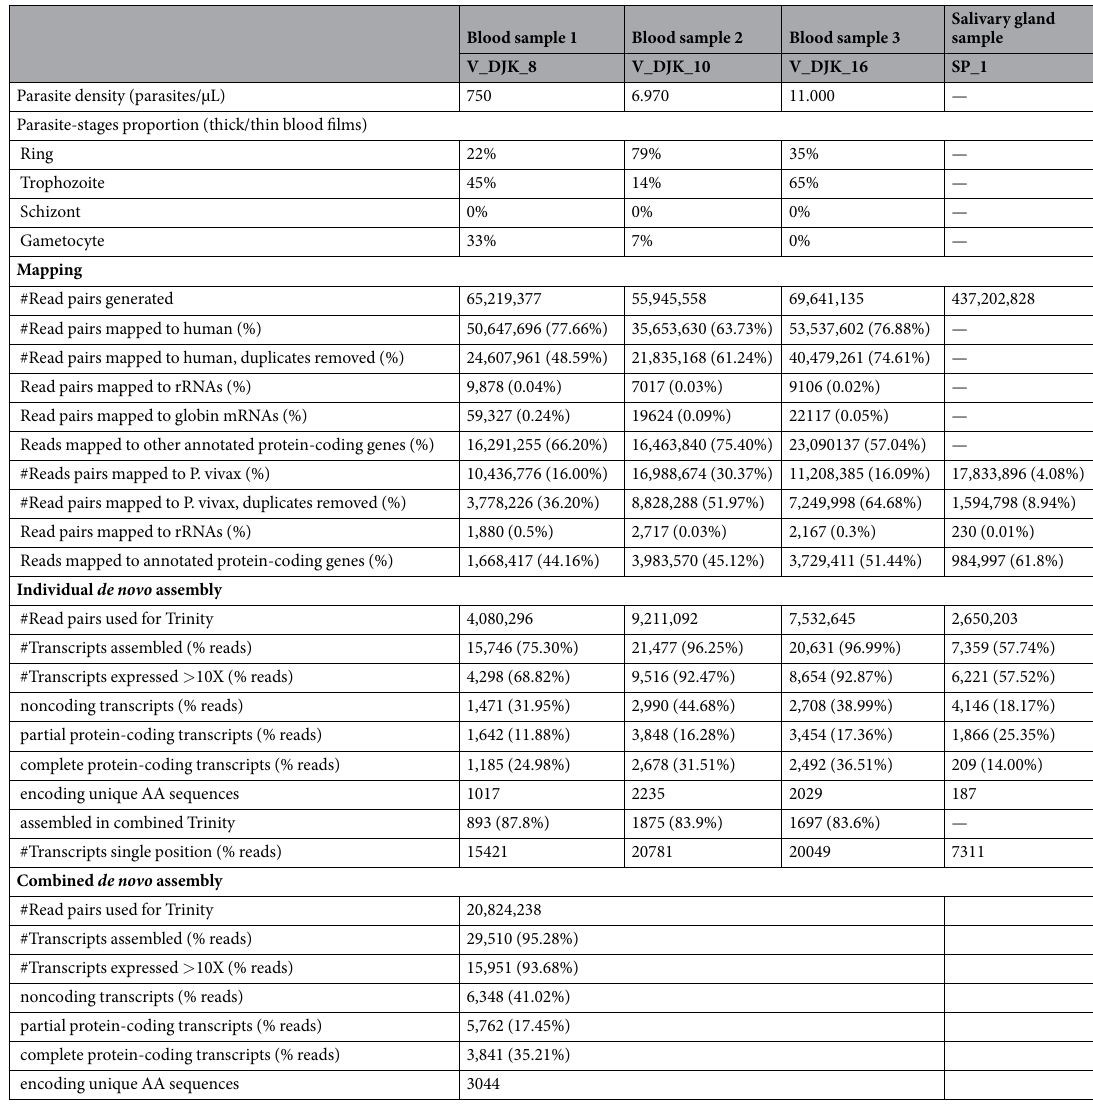
Table 1. Summary statistics of the infections and genomic analyses for the three blood stage samples (V_ DJK_8, V_DJK_10, V_DJK_16) and the sporozoite sample